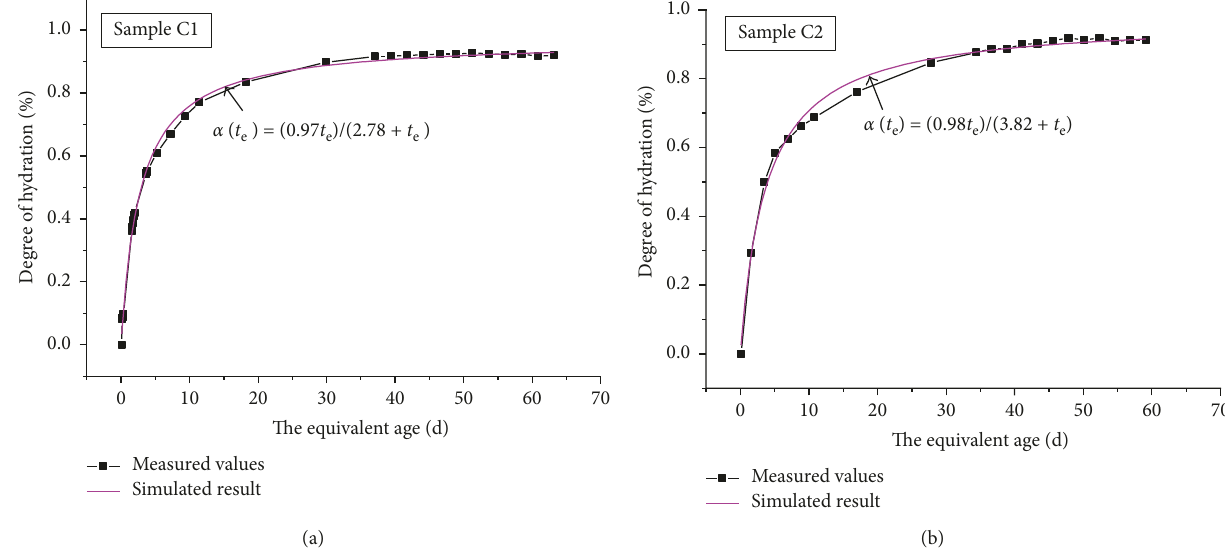
Figure 5: The relationship between the hydration degree and the equivalent